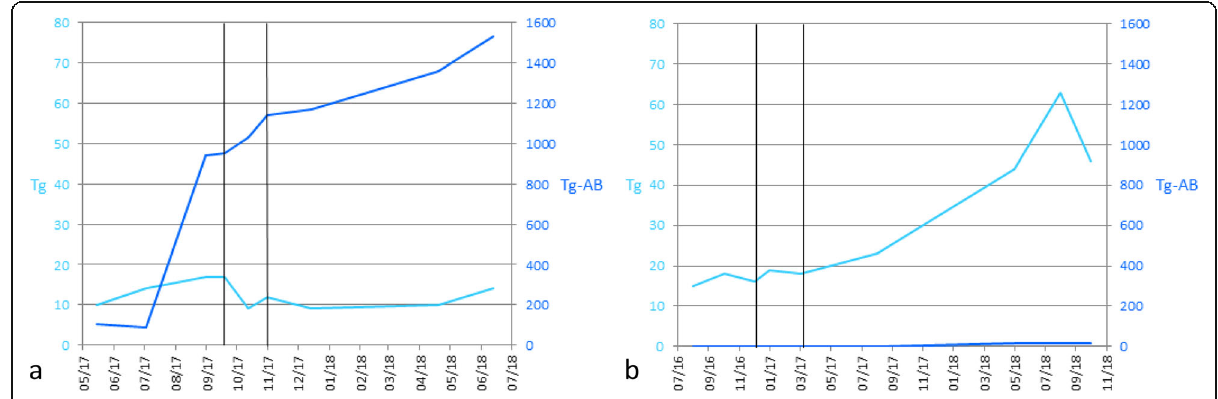
Fig. 3 Tg and Tg antibody (Tg-AB) levels. Black vertical lines indicate the moment of treatment with 177 Lu-PSMA-617. a Patient 2. b Patient